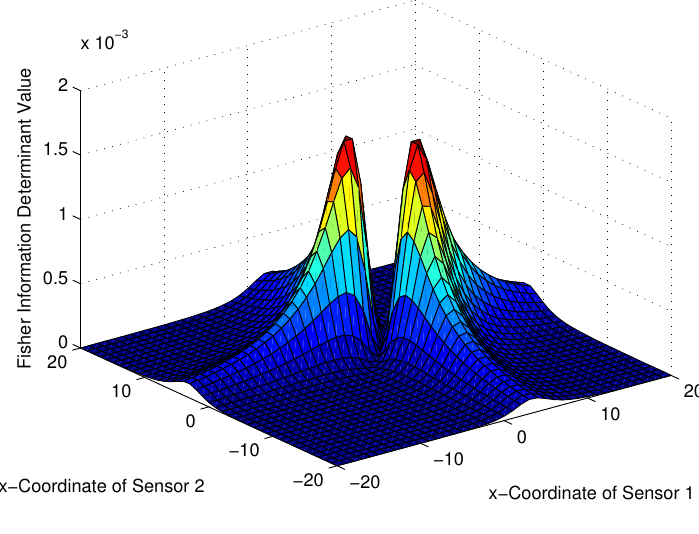
Figure 5. Variation of Fisher information determinant value with the AoA sensors positions.